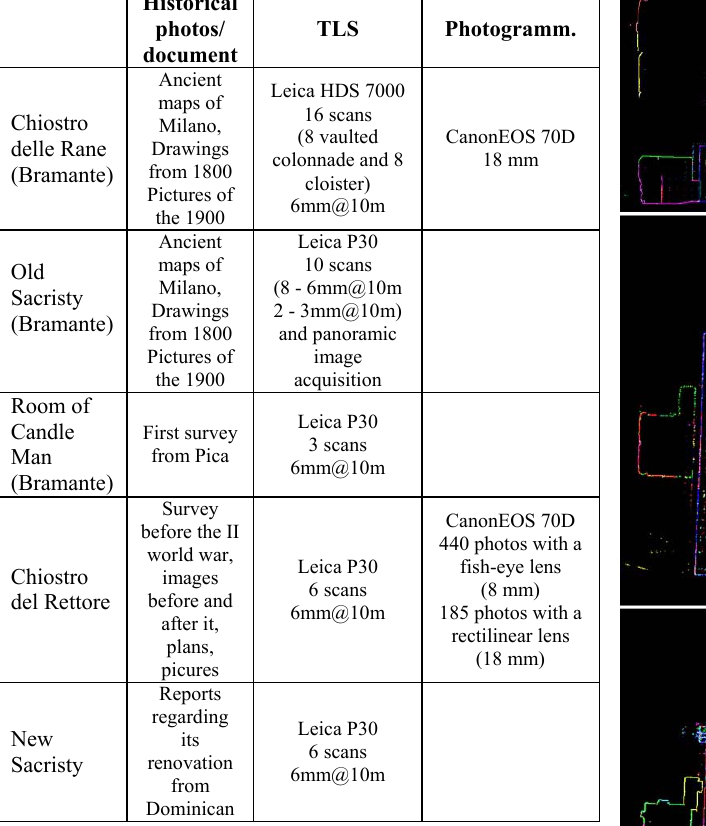
Table 1. The different type of acquisition performed to date for the case study